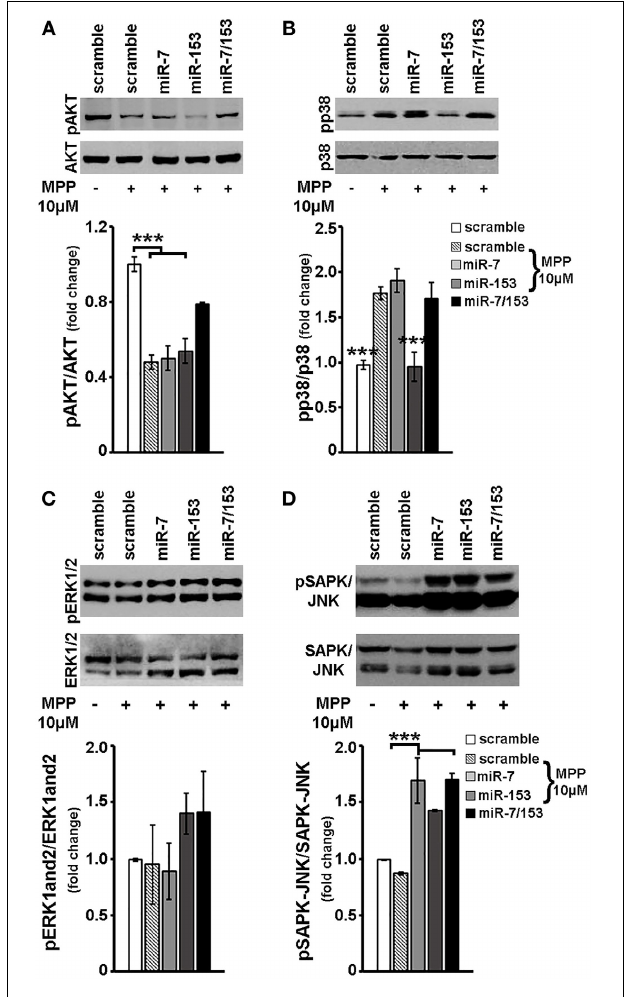
FIGURE 7 | Effect of miR-7 and/or mir-153 overexpression on AKT, p38, ERK-1/2, and SAPK/JNK signaling in MPP + -treated cortical neurons. Six to seven days old primary cortical neurons were transduced with adenoviral particles expressing scramble miR, miR-7, miR-153, or both miR-7/153. After 24h, transduced neurons were exposed for additional 24h to 10 μ M of MPP + . Equal amounts of total protein from lysates of transduced cortical neurons cultured for 24h in the presence of 10 μ M MPP + were analyzed on 10% SDS-PAGE and immunoblotted with antibodies specific for phosphorylated forms of AKT (A) , p38 MAPK (B) , ERK1/2 (C) , and SAPK/JNK (D) . To ensure equal loading membranes were re-probed against AKT, p38 MAPK, ERK1/2, and SAPK/JNK, respectively. Quantification of the results was performed by scanning densitometry. Bars in all the presented graphs depict mean ± s.e.m. Note that miR-7, miR-153, or miR-7/153 altered in an opposite way MPP + -induced changes in intracellular signaling cascades. ∗∗∗ P < 0 .